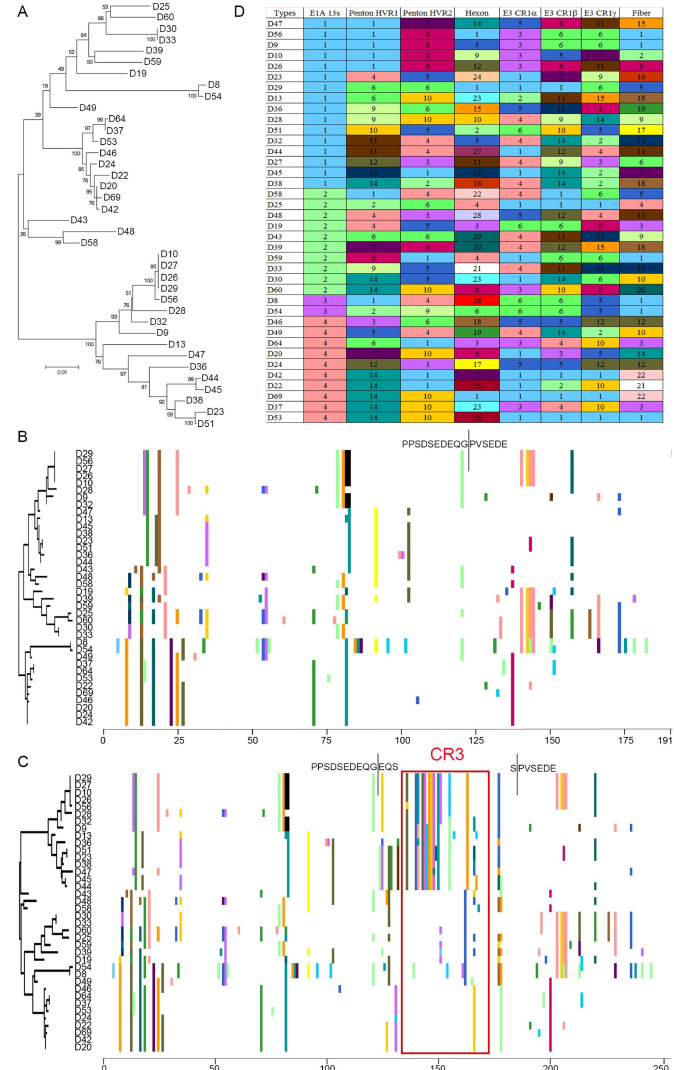
Figure 2. HAdV-D specific analysis of full E1A gene. ( A ) Bootstrap-confirmed (500 replicates) neighbor-joining phylogenetic tree of unspliced E1A gene nucleotide sequences from 38 HAdV-Ds. Bootstrap values below 80 are indicative of low confidence. Proteotyping analysis was performed for full coding sequences of both E1A isoforms, ( B ) 12S and ( C ) 13S, for 38 HAdV-D sequences. No significantly distinct proteotypes were observed for the E1A 12S isoform. The E1A 13S isoform clearly segregated into distinct proteotypes, arbitrarily named group1 (upper) and group2 (lower), due to differences in the CR3 region (as seen by the non-consensus protein signatures). ( D ) E1A recombination was identified in assortment analysis performed in the genomic position order of putative proteotypes for penton base hypervariable loops (HVL1 and HVL2), hexon, three E3 ORFs (CR1 α , β , and γ ) and fiber open reading frames, with respect to E1A 13S proteotypes. For visual representation and understanding recombination at the whole genomic scale, each unique proteotype was assigned a number and